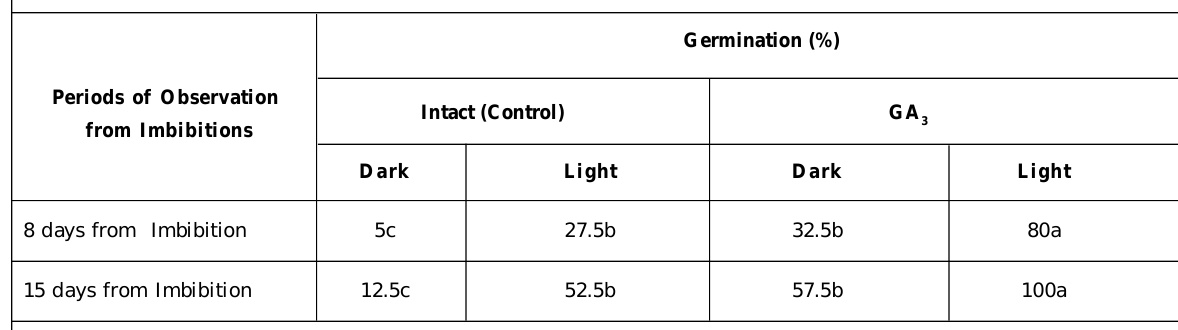
Periods of Observation from Imbibitions